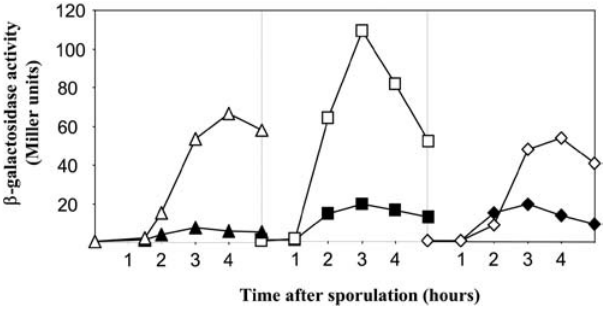
Figure 5. Repression of r E -Controlled Genes by GerR Culture samples from strains PE551 (solid triangles, amyE ::P spoIIM – lacZ ), SW312 (open triangles, amyE ::P spoIIM –lacZ, D gerR ), PE511 (solid squares, amyE :: spoIIP–lacZ ), PE568 (open squares, amyE :: spoIIP–lacZ, D gerR ), PE553 (solid diamonds, amyE ::P yqhV –lacZ ), and PE558 (open diamonds, amyE ::P yqhV –lacZ, D gerR ) were collected at indicated intervals after the start of sporulation in Sterlini–Mandelstam medium and analyzed for b -galactosidase activity. DOI: